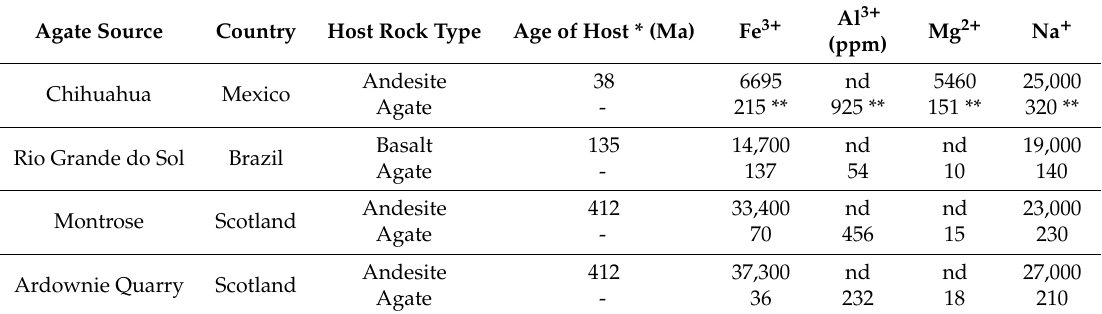
Table 2. Cation Concentrations in Agate and Host in Samples from Mexico, Brazil, and